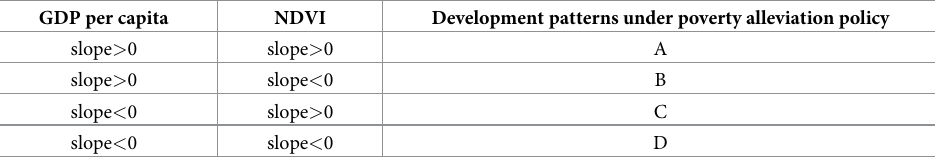
Table 1. Evaluation criteria for the types of impact of poverty alleviation policies on ecological